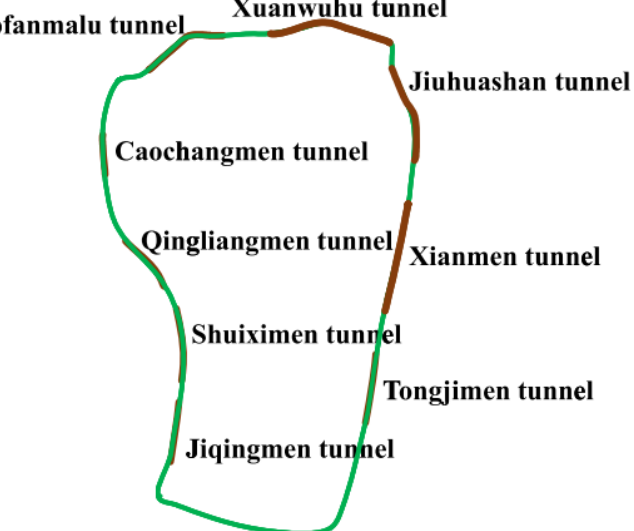
Figure 1. Fast inner ring road of Nanjing City. Table 1. Experimental tunnel length statistics.